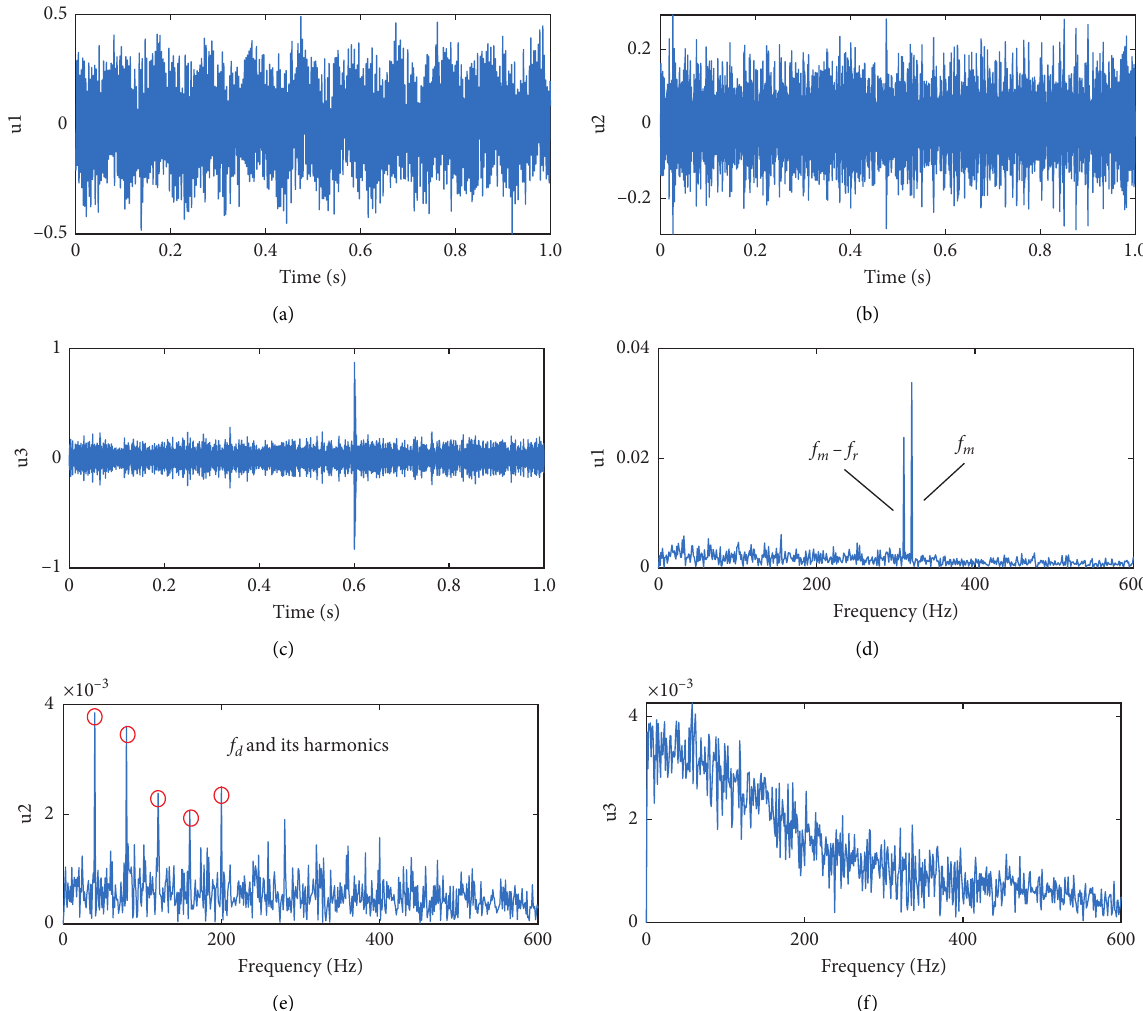
Figure 6: Simulated signals of case 1: signal processing results based on IPAVMD: (a–c) time-domain waveform of each mode and (d–f) the corresponding squared envelope